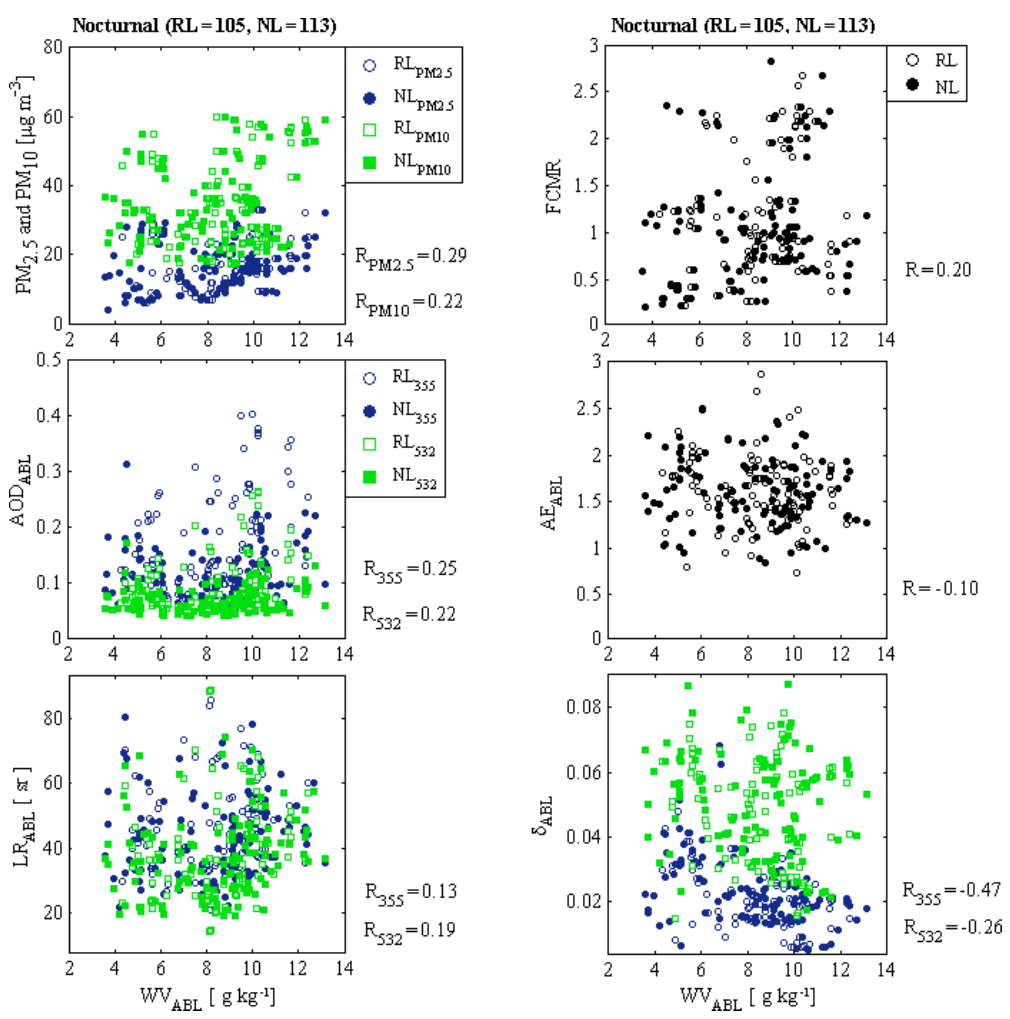
Figure 10. Nighttime hourly averaged water vapour mixing ratio (WV) vs. aerosol optical depth (AOD), lidar ratio (LR), Ångström exponent (ÅE), and linear particle depolarization ratio ( δ ), all derived within the atmospheric boundary layer from the PollyXT lidar at the RS-Lab, at the EARLINET/ACTRIS site in Warsaw, and vs. the fine-to-coarse mass ratio (FCMR) and surface particulate matter (PM 2 . 5 and PM 10 ) measured at the WIOS site in Ursynow, Warsaw, during the July–September period of 2013, 2015, and 2016. Note that the lidar-derived WV is only available at